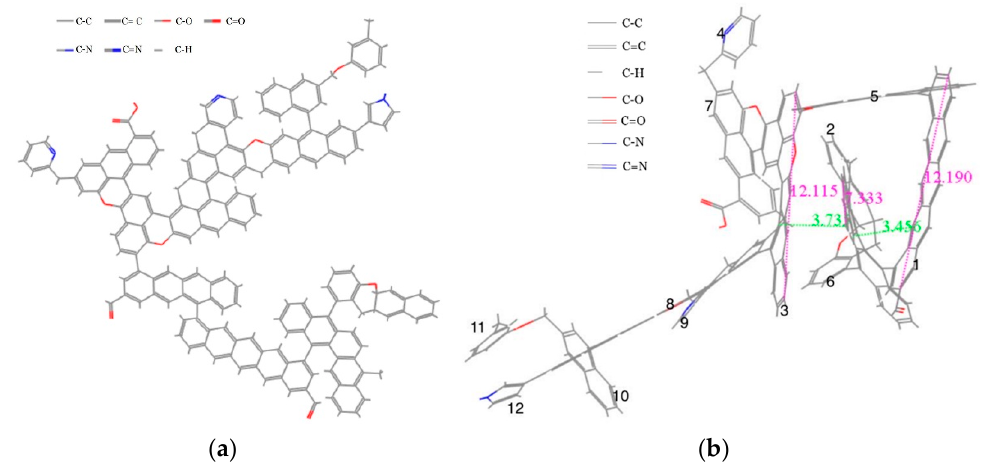
Figure 7. Macromolecular structure model of gas coal before and after optimization: ( a ) before optimization; ( b ) after optimization.